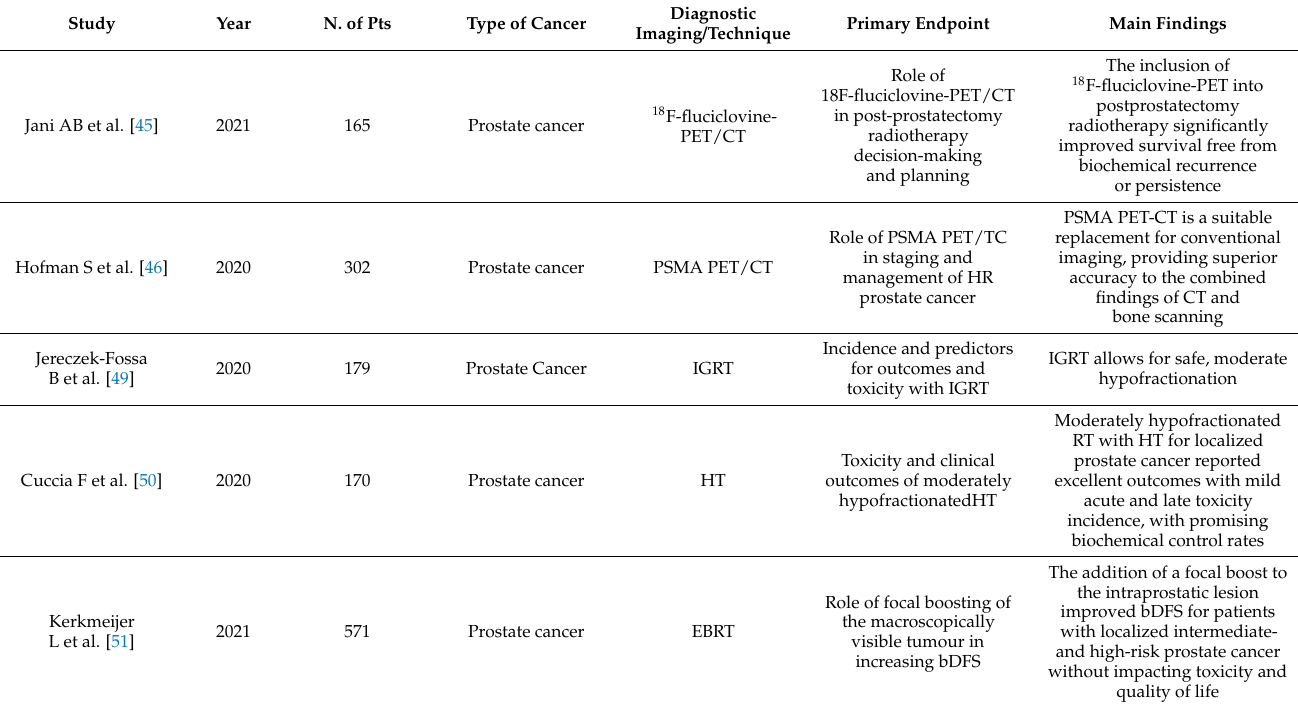
Table 6. Implementation of novel imaging in radiotherapy planning in prostatic